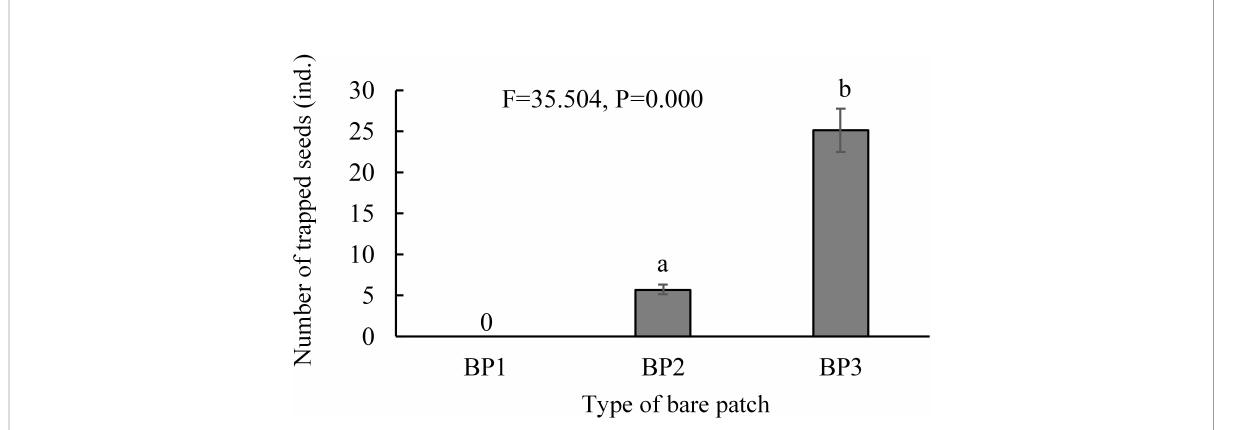
FIGURE 5 Number of trapped seeds in the three types of bare patch and natural saltmarsh. BP1, BP2, and BP3 represent complete-enclosed, semi- enclosed and open bare patches, respectively (N = 54). Data are means ± SE. Signi fi cant differences are shown by different letters above the bars.